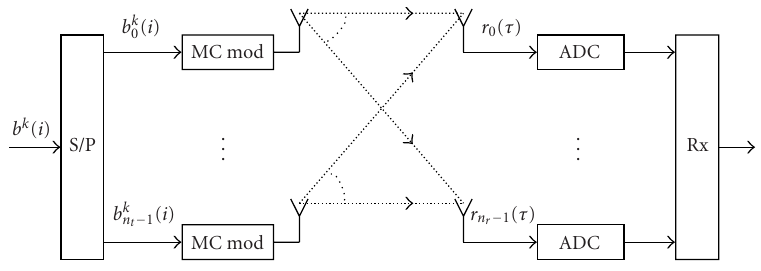
Figure 1: Scheme of a communication system with multiple transmit and receive